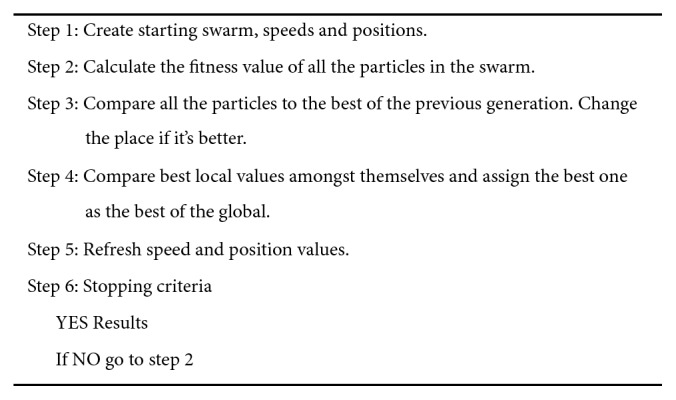
The pseudocode of the PSO [20].